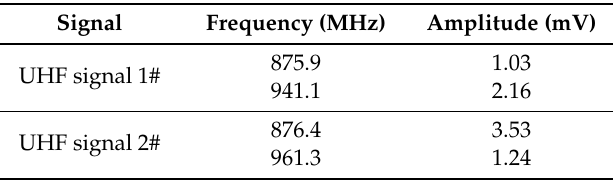
Table 5. Calculated frequencies and amplitude of narrowband noise in field detection.